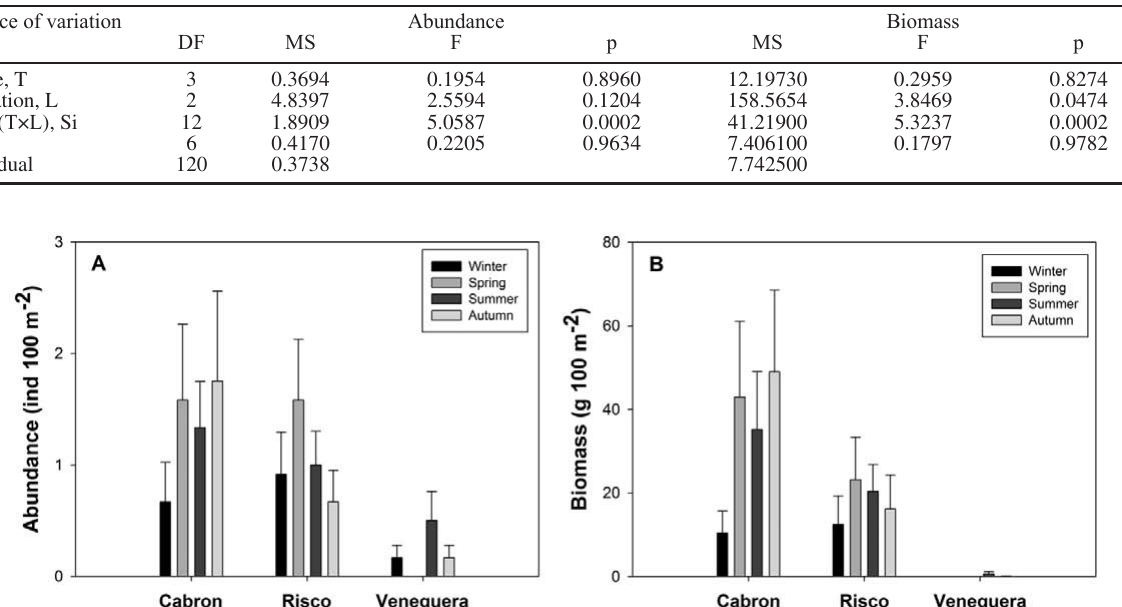
Fig. 5. – Mean abundance (A) and mean biomass (B) of the pearly razorfish, Xyrichtys novacula , at each location and time, recorded through the SNs. Error bars indicate standard error of the means.